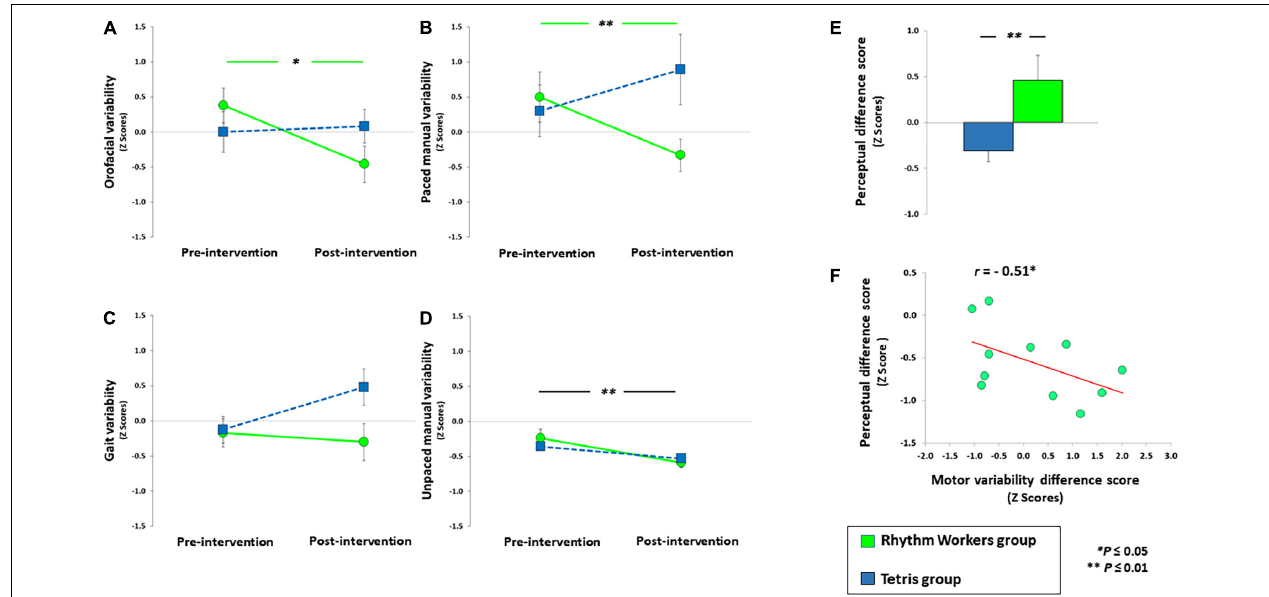
FIGURE 1 | Performance of patients playing Rhythm Workers and Tetris in the rhythmic oral diadochokinesis (A) , paced manual (B) , gait (C) , and unpaced manual (D) tasks. (E,F) The post- minus pre-intervention difference score in the rhythm perception task, for each group. A positive difference score indicates an improvement of rhythm perception following the intervention. (F) The relation between an improvement in rhythm perception (perceptual difference score) and the change in rhythmic variability post- minus pre-intervention averaged across motor domains (post-motor variability difference score) for the Rhythm Workers group. A negative motor variability difference score indicates an